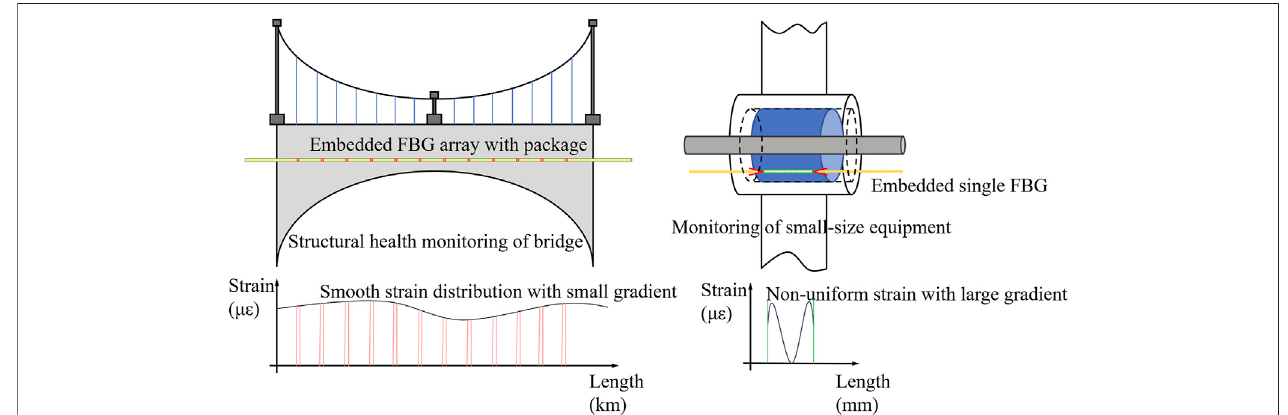
FIGURE 1 | Sensing scheme of sizable and small-size equipment with the related measuring strain distribution.